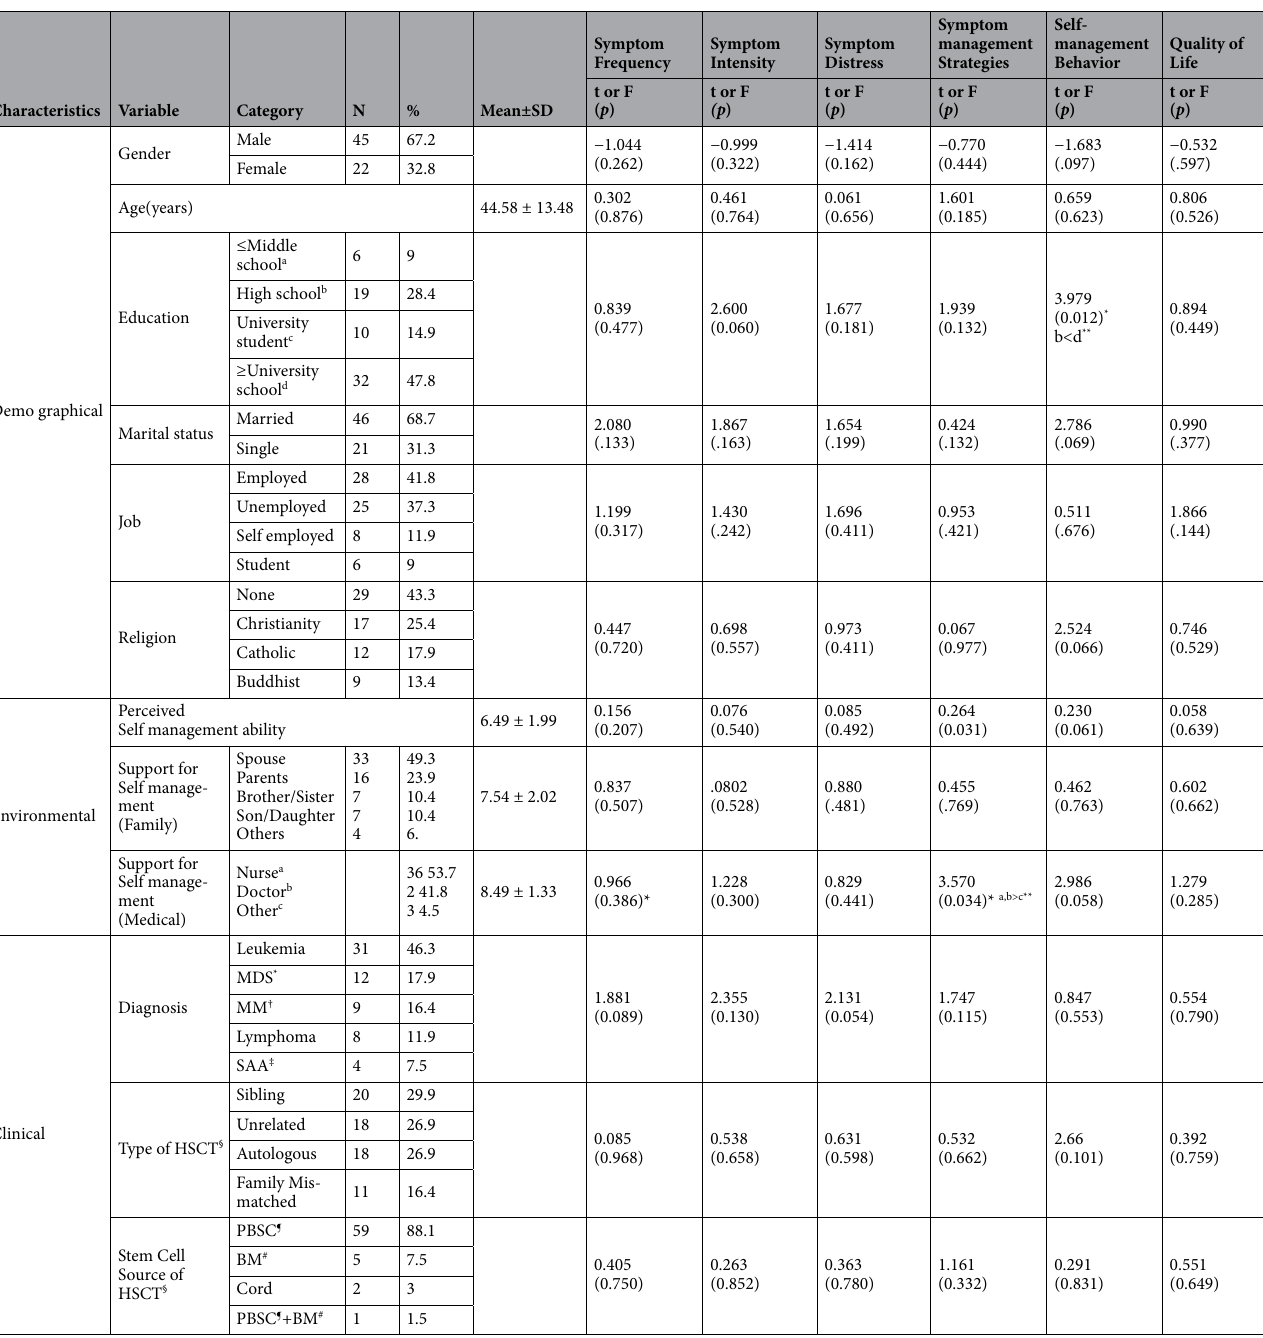
Table 1. In variable of Symptom Management Model according to Characteristic. Post hoc : * p < .05, ** p <